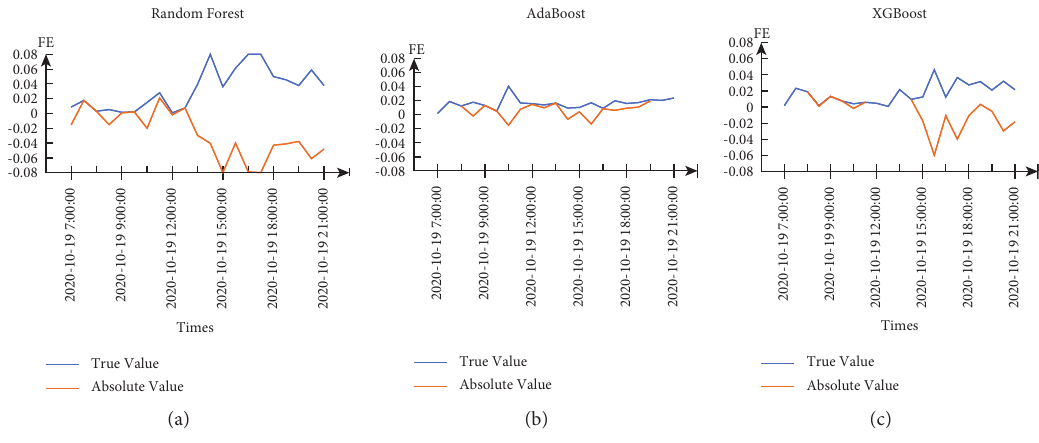
Figure 7: Fitting error curves of three algorithms. (a) Random forest. (b) AdaBoost. (c) Table 2: The DT model evaluation results.